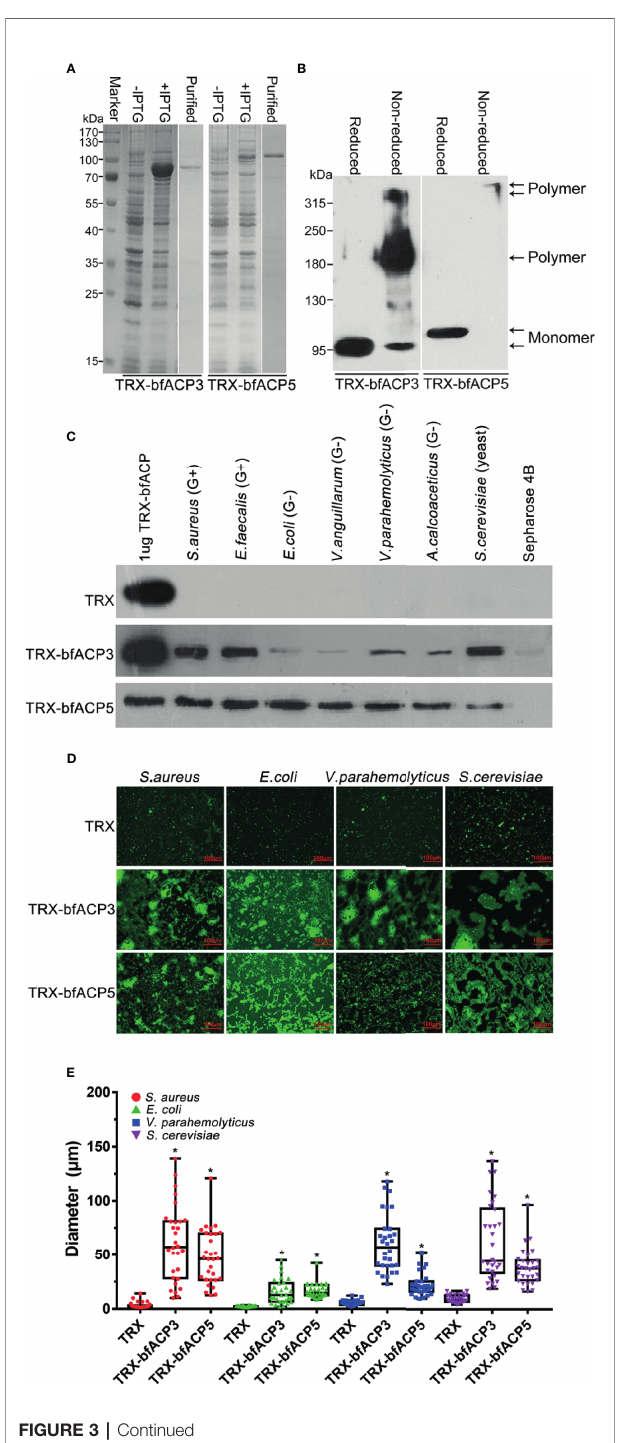
FIGURE 3 | Binding and aggregation of the microbes by bfACP3 and bfACP5. (A) SDS-PAGE analysis of samples taken during the puri fi cation of recombinant TRX-bfACP3 and TRX-bfACP5. (B) Reducing and Non-reducing SDS-PAGE of ACPs. The bands corresponding to the monomer or oligomer were marked. (C) The binding of microorganisms by recombinant TRX- bfACP3 and TRX-bfACP5 protein. Approximately 2×10 6 living microbes were incubated with 1 m g TRX fusion proteins in 1 mL PBS at 4°C overnight and the stirringly washed pellets were subjected to the SDS-PAGE and detected by Western blot with anti-6×His monoclonal antibody. One representative experiment out of three is shown. (D) Aggregation of the microbes by TRX- bfACP3 and TRX-bfACP5. 10 m g TRX fusion proteins were incubated with 50 m l FITC-labeled S. aure us (2 × 10 8 cells/mL), E coli (2 × 10 8 cells/mL), V. parahemolyticus (2 × 10 8 cells/mL) or S. cerevisiae (2 × 10 7 cells/mL) at room temperature in the dark for 2h, respectively. The agglutinating reaction was examined using fl uorescence microscopy. (E) Box plot showing the diameters of green puncta in microbial aggregation assays. Box plot explanation: upper horizontal line of box, 75th percentile; lower horizontal line of box, 25th percentile; horizontal bar within box, median; upper horizontal bar outside box, maximum value; lower horizontal bar outside box, minimum value. * p < 0.05 versus